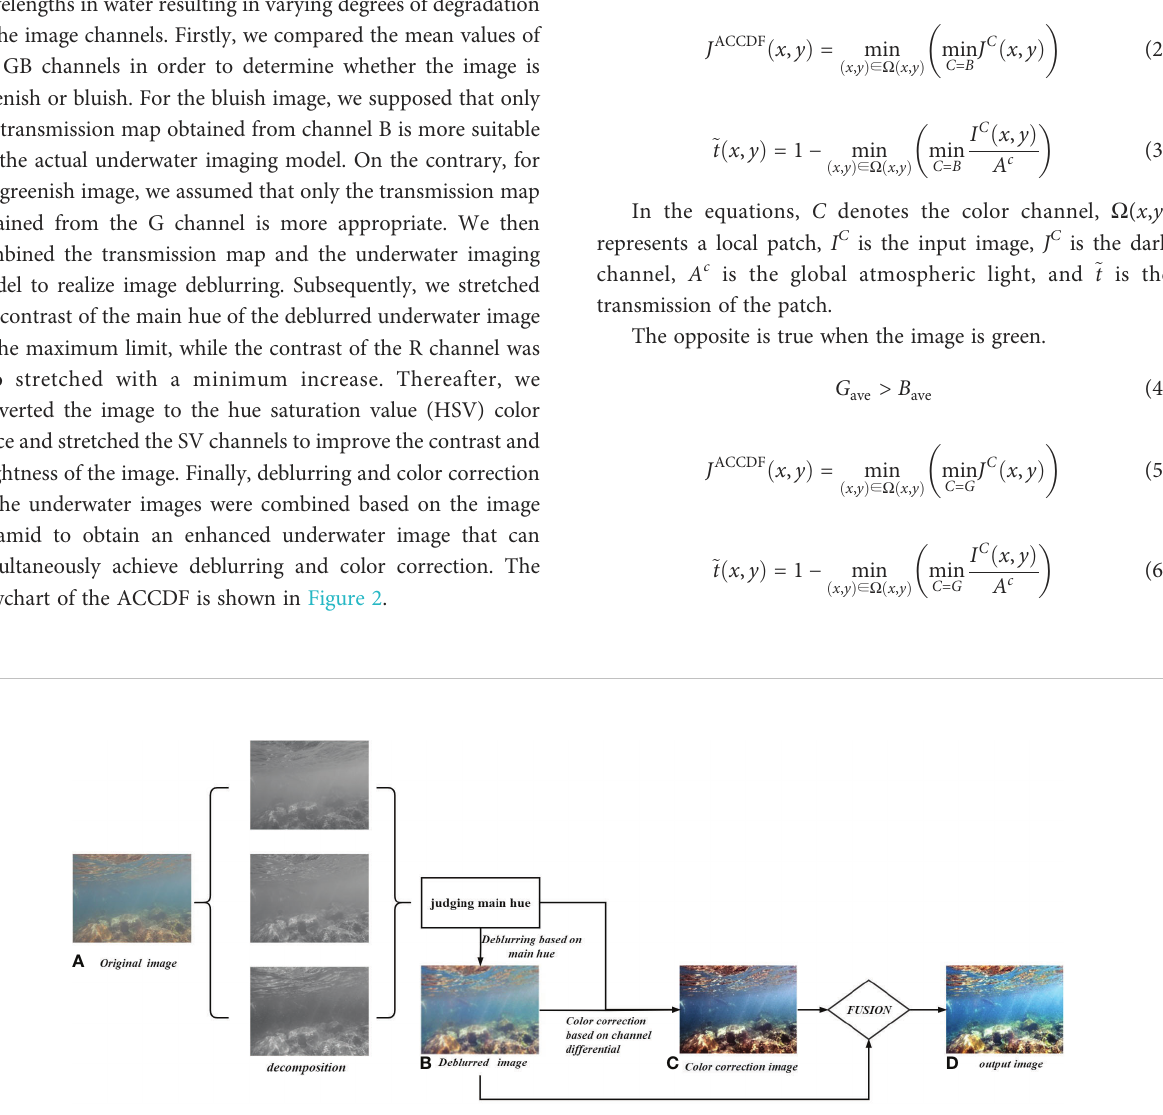
FIGURE 2 Flowchart of adaptive correction of channel differential and fusion (ACCDF). (A) Original image. After decomposition, information on the three channels was extracted. (B, C) Images obtained by deblurring and color correction based on the mean values of each channel. (D) Image obtained from the fusion of (B, C) using the FUSION